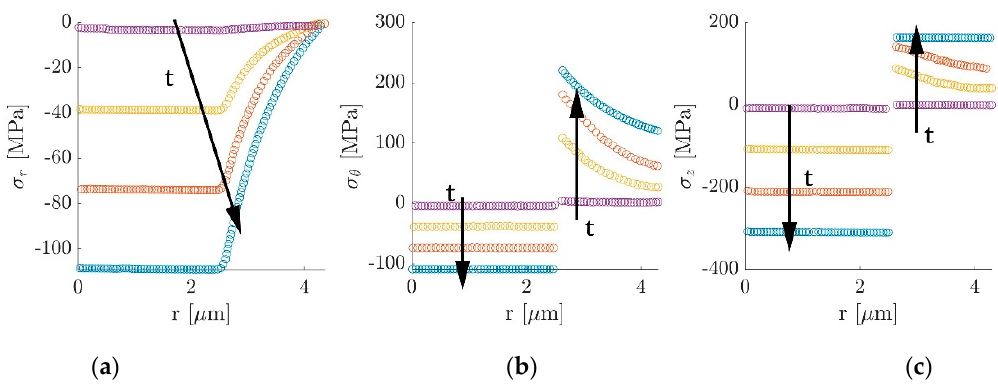
Figure 26. Stress distribution during charging: ( a ) radial stress; ( b ) hoop stress; ( c ) axial stress from Xu et al. [100].